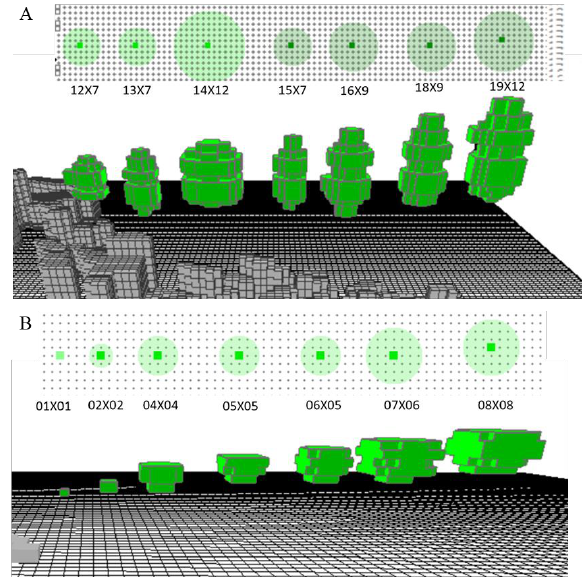
Figure 4. Selected tree models for pine (A) and Balete trees (B) built in ENVI-met Albero based on the field - acquired data on vegetation parameters. The identified Balete and pine trees differ in terms of tree height, canopy height, and crown width. The study developed specific model for each height and width ratio of the trees as this may affect the total LAD per height